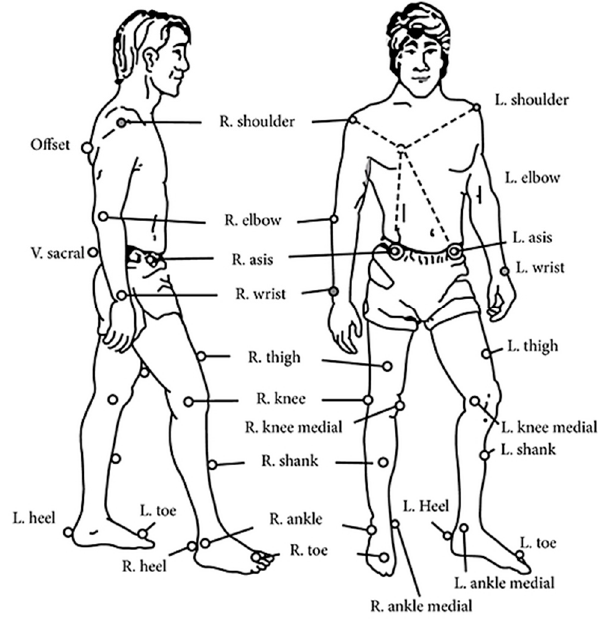
Figure 2. The Helen Hayes model.